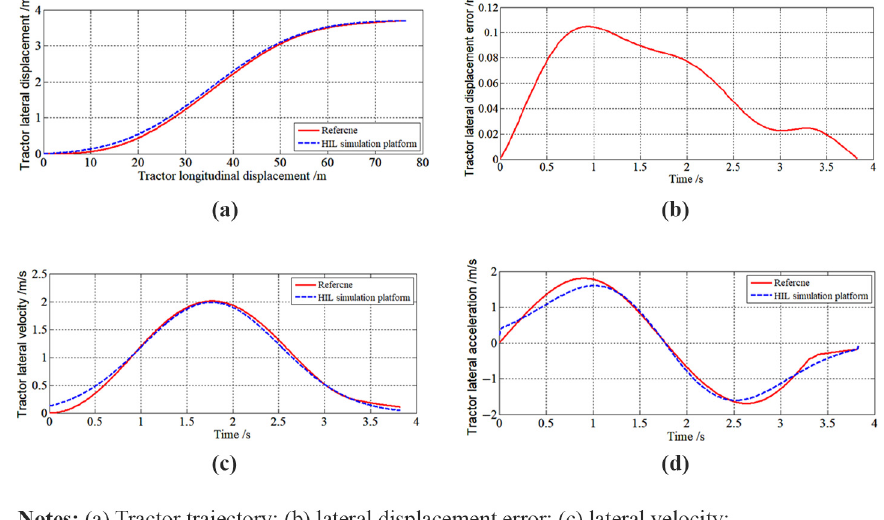
Figure 13 Tractor motions in lane change obtained by HIL simulation platform